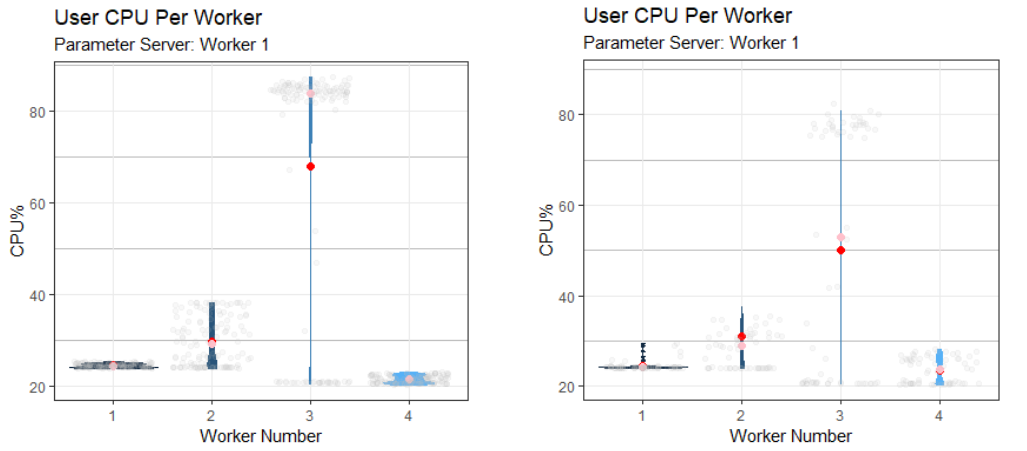
Figure 13. CPU Usage of the baseline (left) and Traffic Based (right) architectures. Red dots indicate mean value, while pink dots indicate median. The continuous lines encode the standard deviation around the mean.